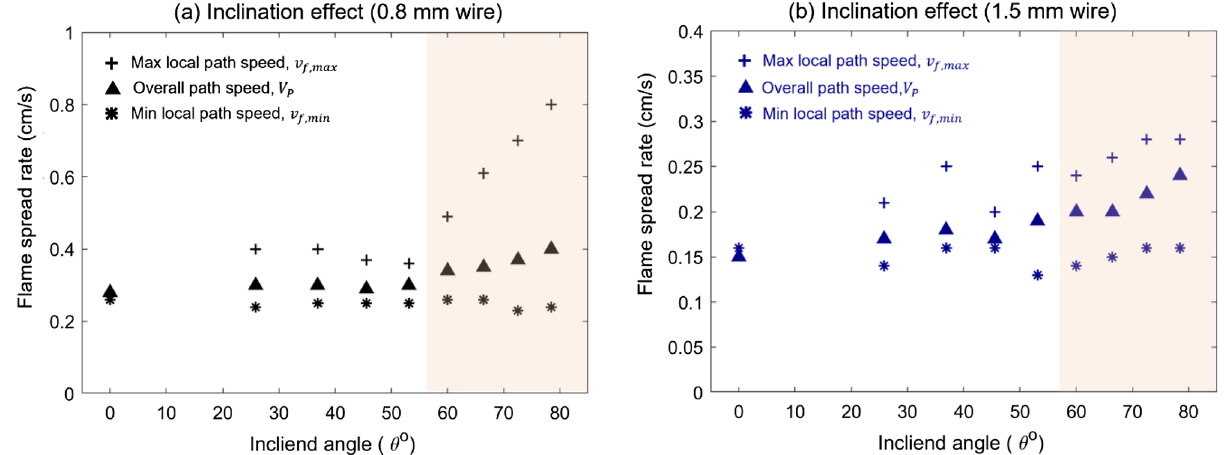
Figure 6. The inclination effect on characteristic spread rates for typical thin fuels ( a ) 0.8-mm thin wire and ( b ) 1.5-mm thin wire.